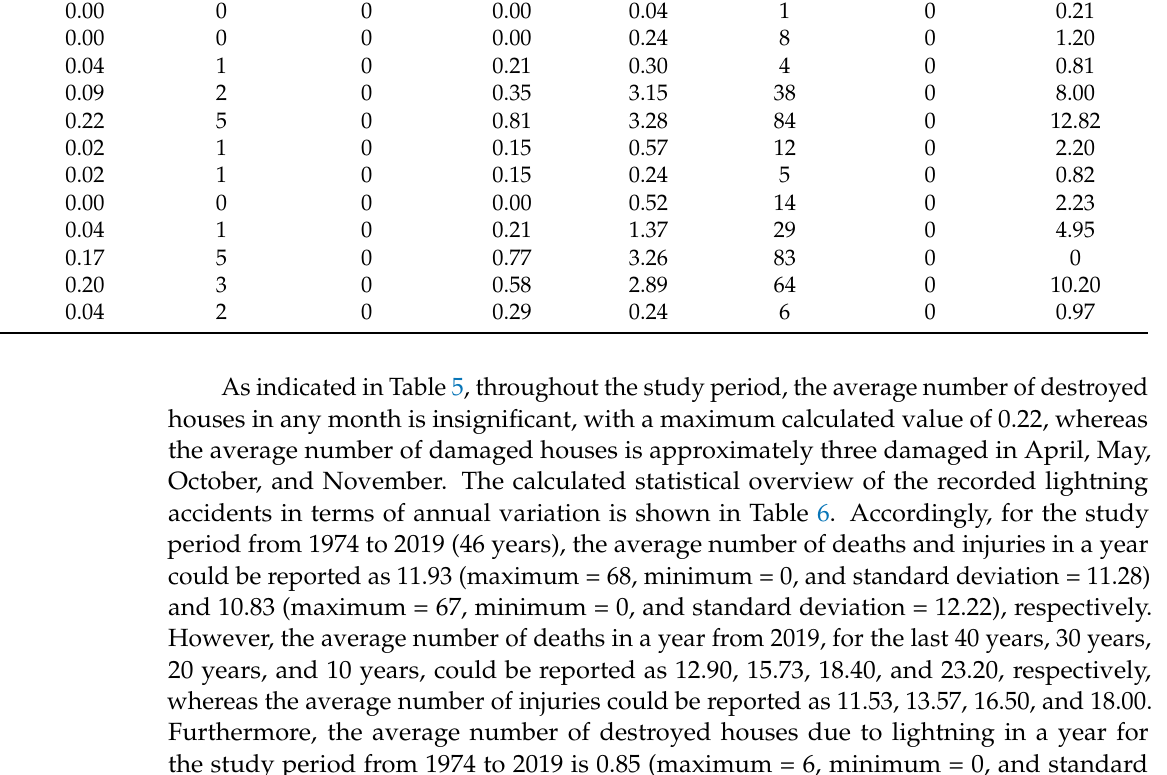
Table 5. Statistics of the monthly variations of property damage in Sri Lanka due to lightning, from 1974 to 2019. Number of Houses Destroyed Number of Houses